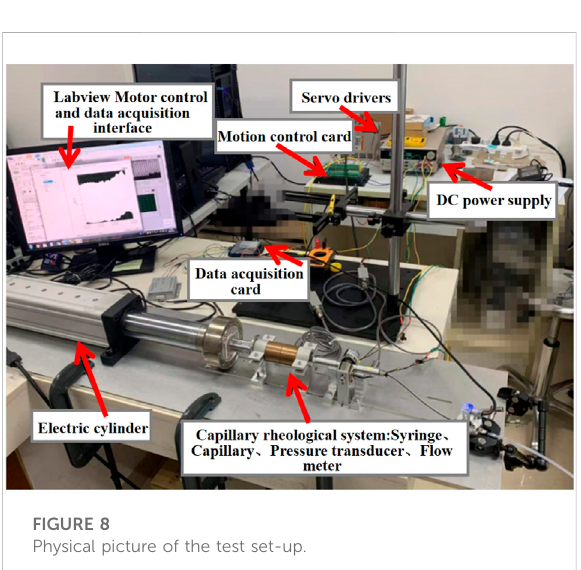
FIGURE 8 Physical picture of the test